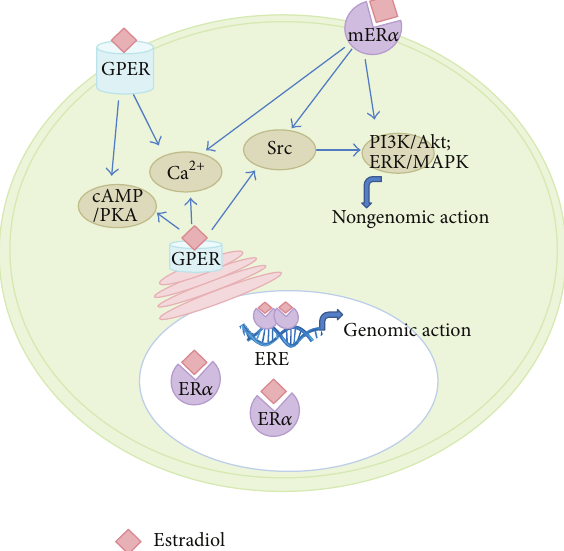
Figure 1: Schematic overview of estradiol-mediated genomic sig- naling pathway via nuclear ER 𝛼 and rapid nongenomic signaling pathways via GPER and membrane isoform of ER 𝛼